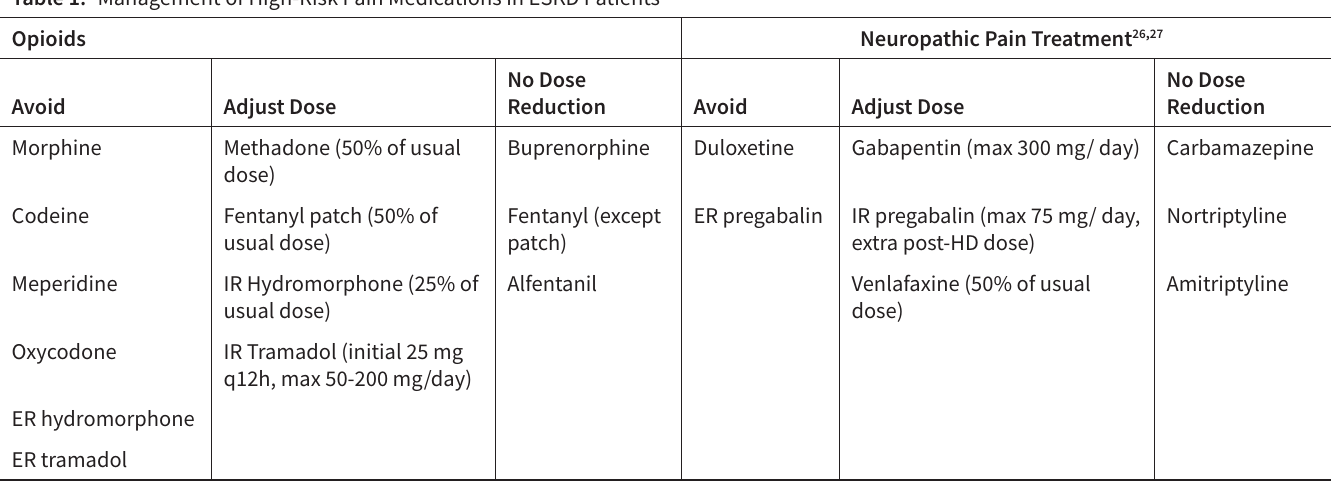
Table 1. Management of High-Risk Pain Medications in ESKD Patients